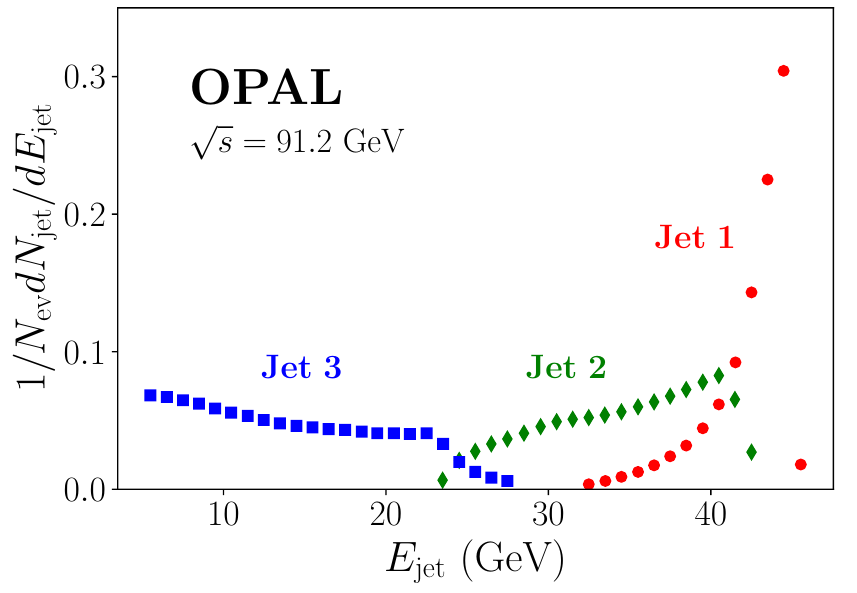
Figure 18 . OPAL results for the energy spectrum of the leading jet (Jet 1) and the first two subleading jets (Jet 2,3) using 3-jet events. Data taken from [142].